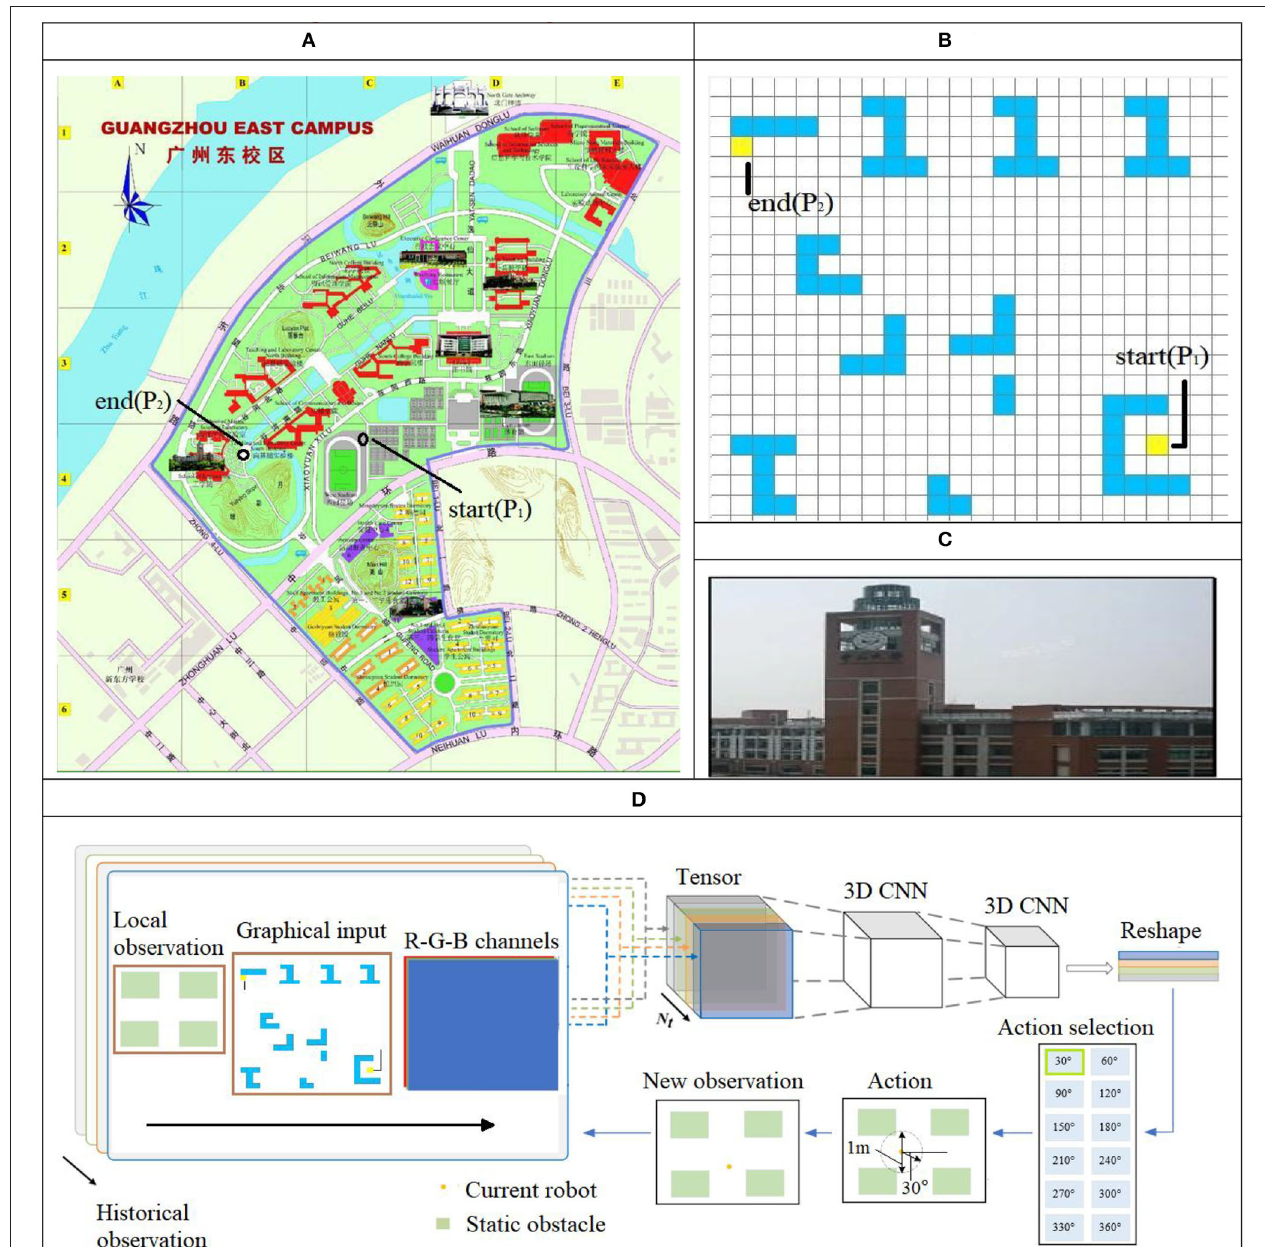
FIGURE 3 | Scene description and modified reinforcement learning (MRL). (A) Top view of path planning environment. (B) Obstacle distribution. (C) Detection object. (D) Process of MRL. size (0.5 m), at the same time, approach the target position